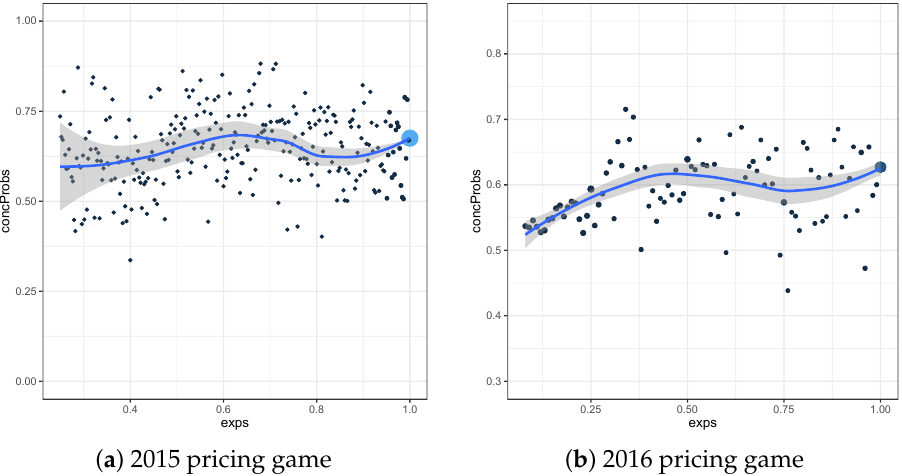
≈ ( λ ,0.05 ) based on the dataset of the 2015 and 2016 pricing Figure 6. Weighted-mean-plot for ˆC M ,0,1 + game. It is obtained by the extended marginal approximation, using 50 boundary values that can differ for the O - and 1